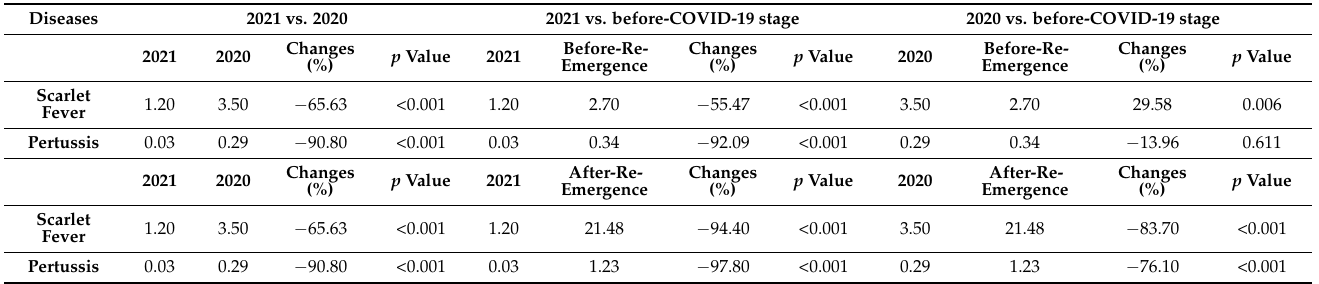
Table 2. Changes in the average yearly incidences (1/100,000) of scarlet fever and pertussis in 2020 and 2021 compared to previous years in Hong